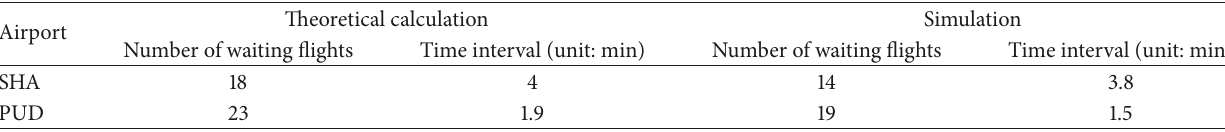
Table 12: Time interval of ATC clearance and number of waiting flights comparison between simulation data analysis and theoretical calculation at airport.